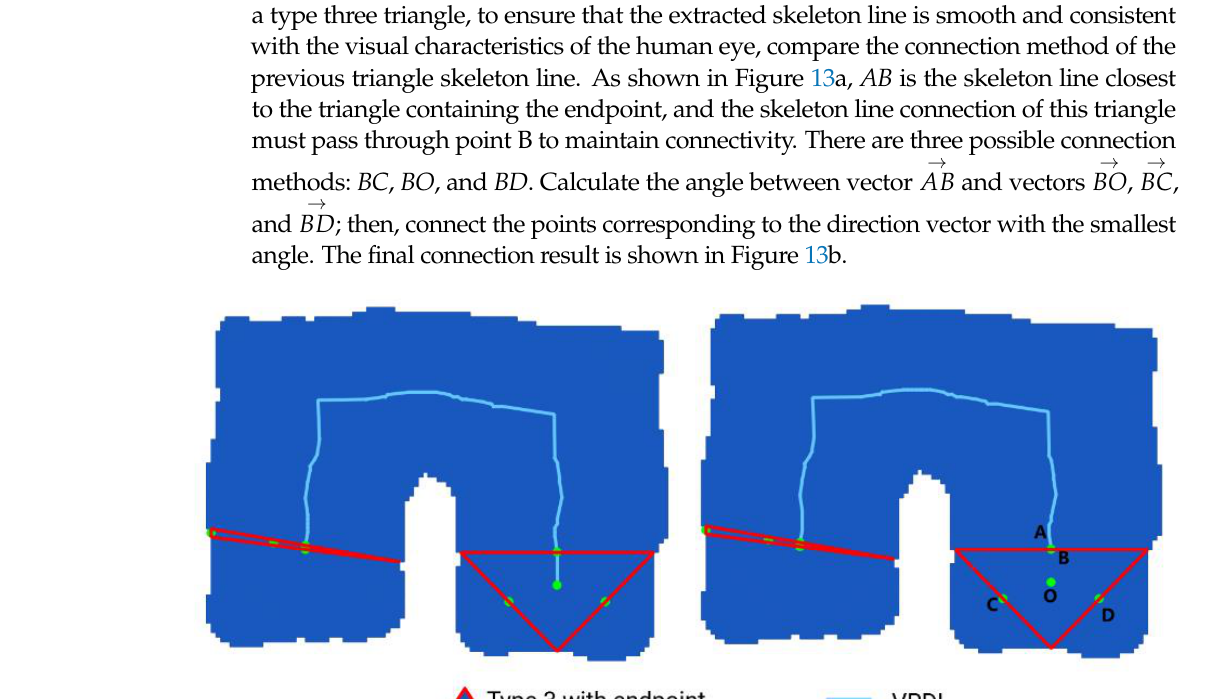
(8) Figure 12. Type three with corner points. ( a ) C-shaped building with corner point; ( b ) Result of VRDI method for corner point.